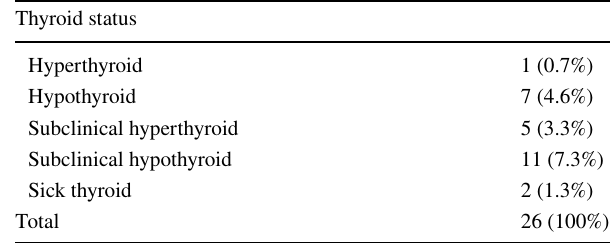
Table 1 Thyroid dysfunction in patients with